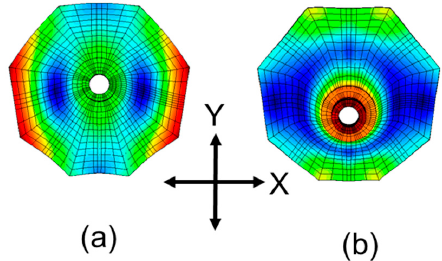
Figure 9. In-plane first and second mode shapes when only the top electrodes are electrically excited. Deformations are in the y -axis direction. ( a ) First in-plane mode at 68 kHz, ( b ) Second in-plane mode at 154.5 kHz.